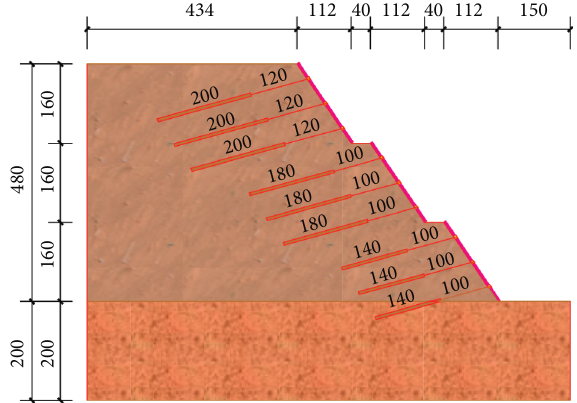
Figure 2: Dimensions of the centrifugal model slope (unit: mm).